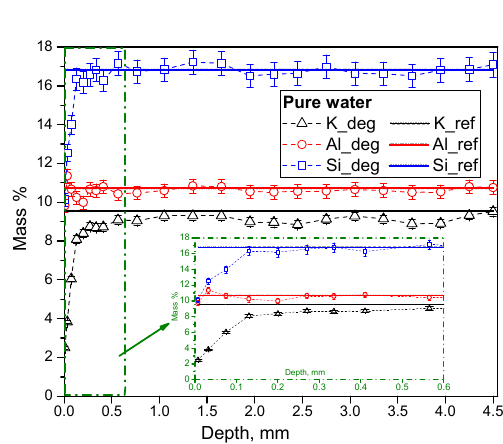
Figure 11. Degradation profile after leaching in ultra ‐ pure water: obtained as a statistical analysis of EDS mappings (Fig. 9) per depth ranges (indicated on x ‐ axis).